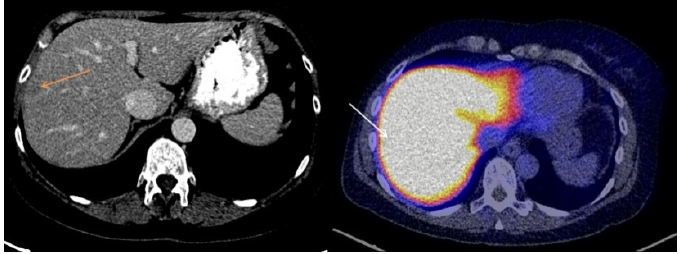
Figure 3. A case of an ER+ liver metastasis with [ 18 F]-FES uptake equal to physiological liver uptake.